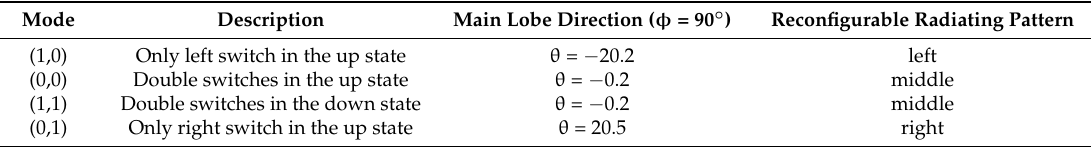
Table 2. The reconfigurable radiating pattern main lobe direction and its associated radio frequency